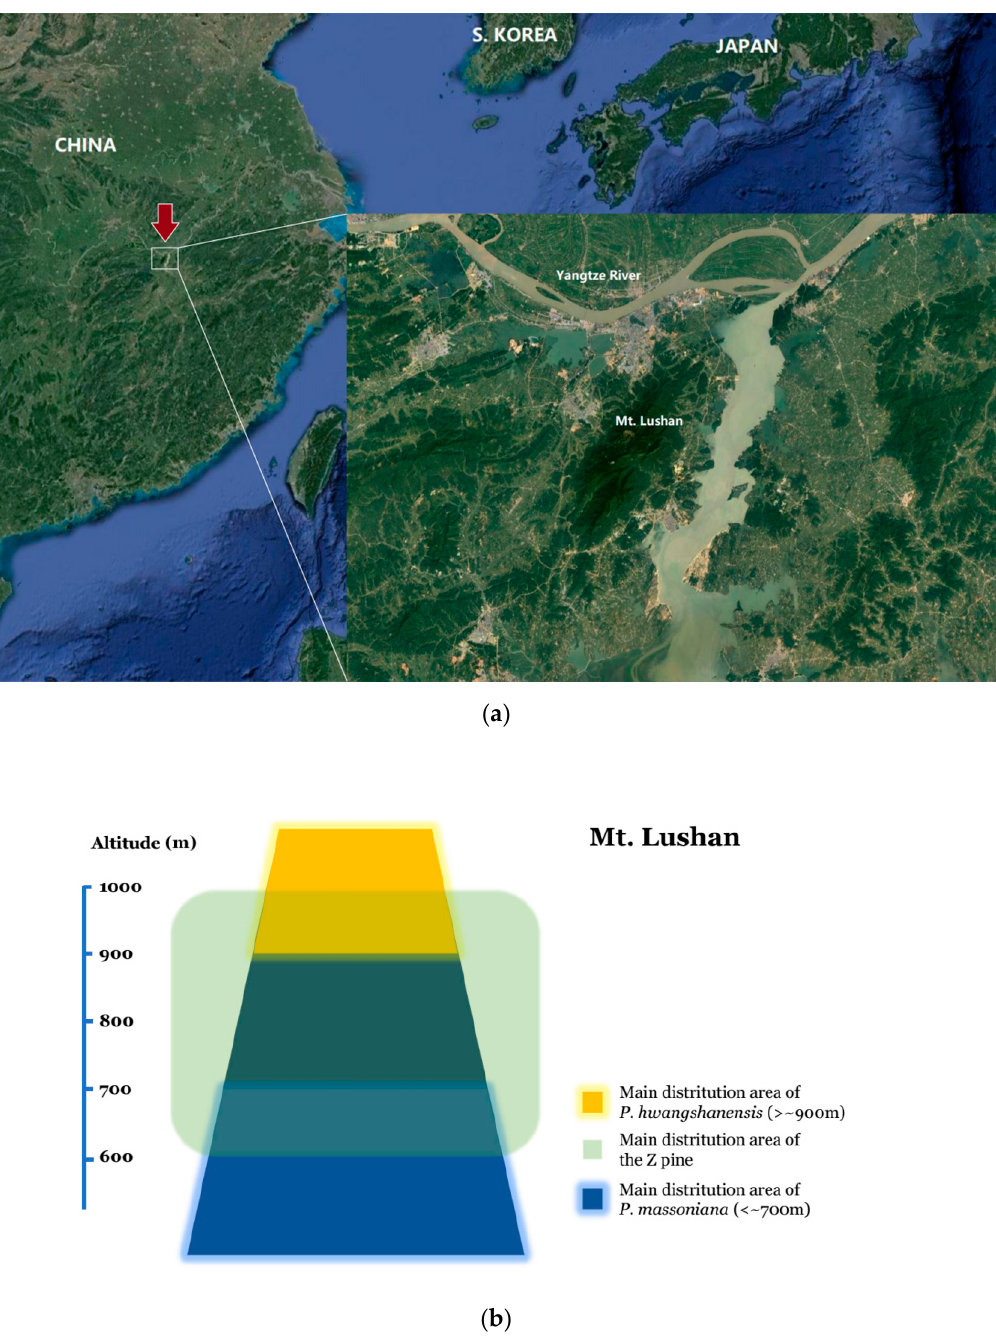
Figure 1. ( a ) Location of Mountain Lushan. Mt. Lushan lies in Jiujiang City, Jiangxi Province, China. The Great Han Yang Peak, the highest point of the mountain, is 1474 m high. The local climate is humid, subtropical; ( b ) Schematic diagram of main distribution area of P. hwangshanensis , the Z pine and P. massoniana on Mt. Lushan.